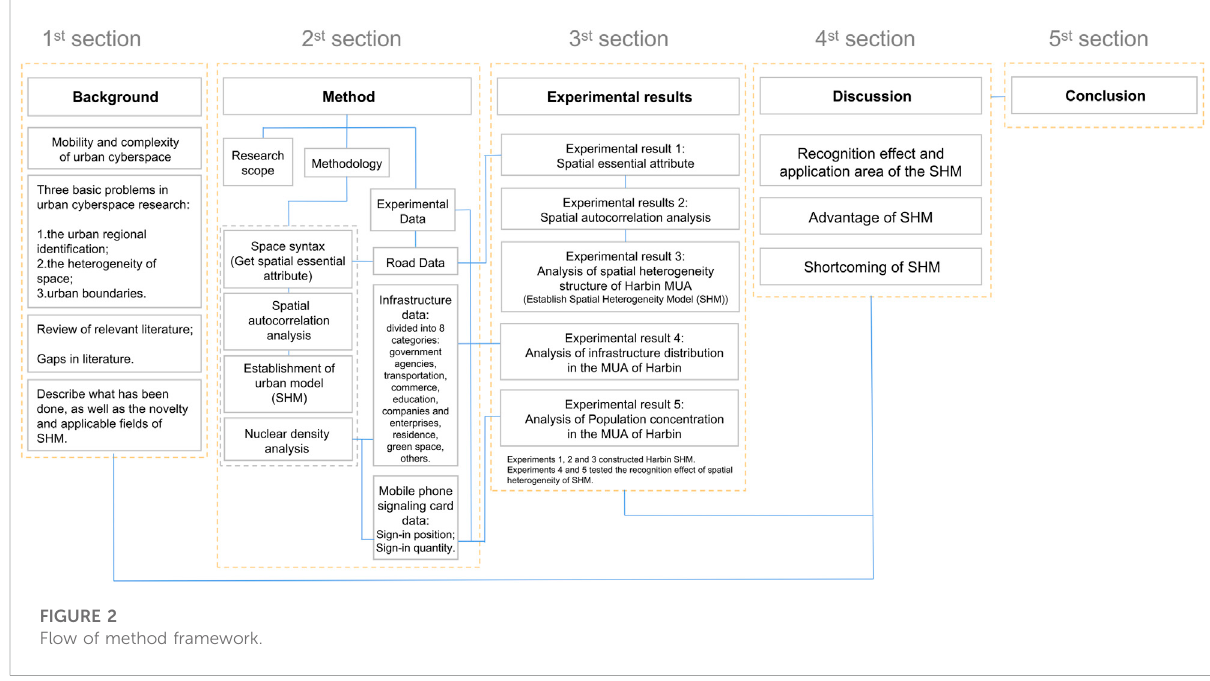
FIGURE 2 Flow of method